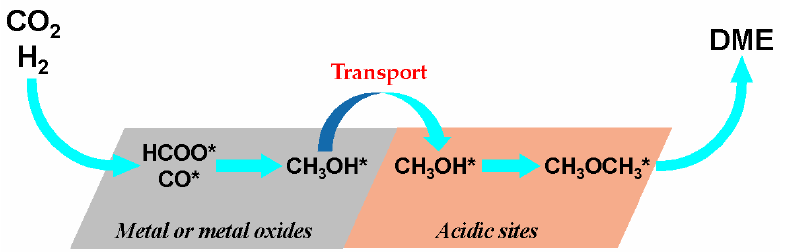
Figure 11. Scheme for the reaction pathway of the one-step CO 2 hydrogenation to DME.